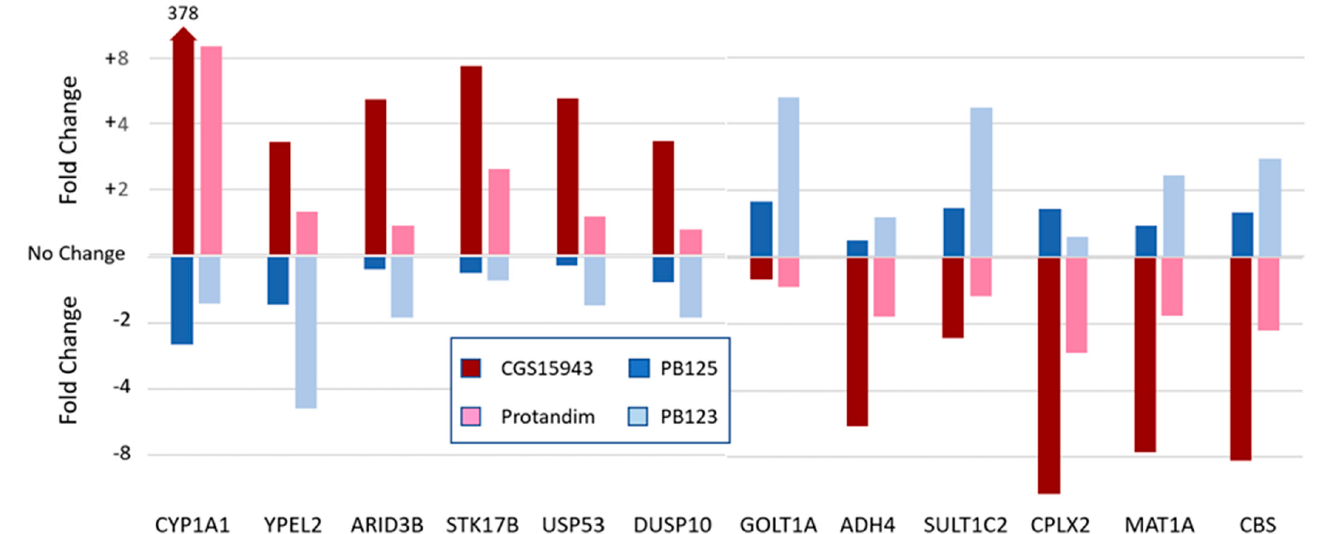
Figure 3. Two groups of genes are induced in opposite directions by the four Nrf2 activators, with clear similarity between the CGS15943 and Protandim pair, and clearly opposite similarity between the PB123 and PB125 pair. Details have been previously published in [97].